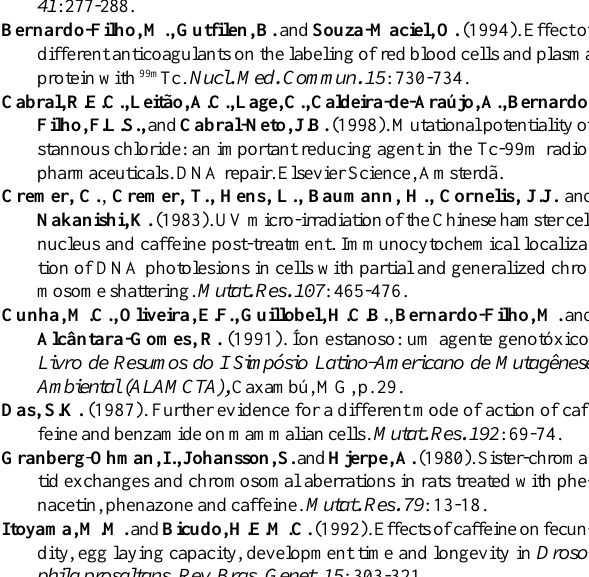
Table I - Total fecundity in the experiments. Drugs and doses per ml of banana-agar medium: t